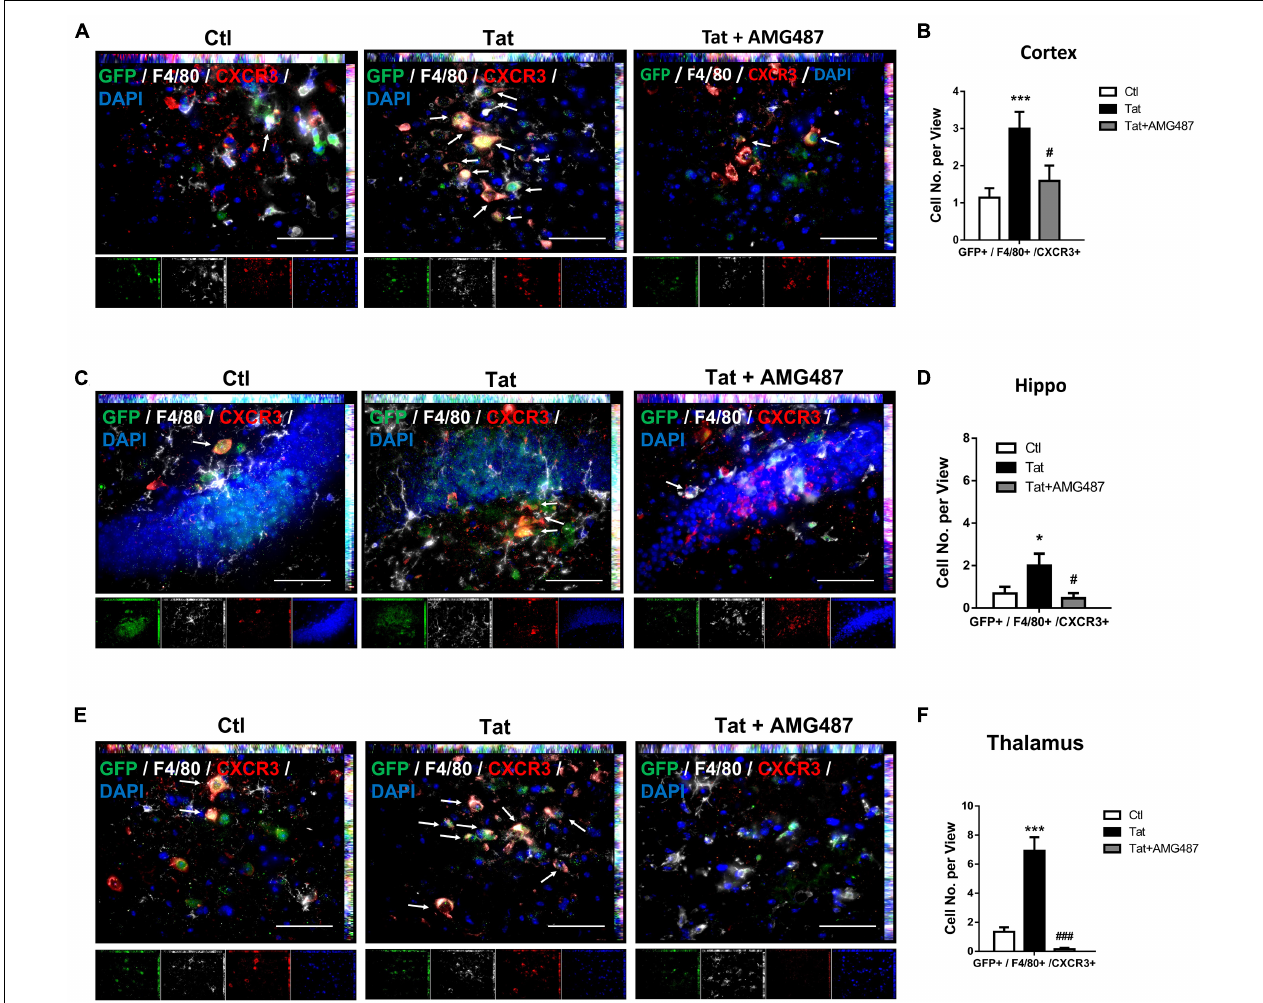
FIGURE 8 | HIV Tat-mediated upregulation of CXCR3 facilitated monocyte transmigration in mice. (A) Representative images of CXCR3+/GFP+/F4/80+ cells in the cortex of mice administrated CXCL10. n = 4 per group. Arrow: CXCR3+/GFP+/F4/80+ cells; bar, 50 µ m. (B) Quantification of CXCR3+/GFP+/F4/80+ cells in the cortex of mice administrated CXCL10. (C) Representative images of CXCR3+/GFP+/F4/80+ cells in the hippocampus of mice administrated CXCL10. n = 4 per group. Arrow: CXCR3+/GFP+/F4/80+ cells; bar, 50 µ m. (D) Quantification of CXCR3+/GFP+/F4/80+ cells in the hippocampus of mice administrated CXCL10. (E) Representative images of CXCR3+/GFP+/F4/80+ cells in the thalamus of mice administrated CXCL10. n = 4 per group. Arrow: CXCR3+/GFP+/F4/80+ cells; bar, 50 µ m. (F) Quantification of CXCR3+/GFP+/F4/80+ cells in the thalamus of mice administrated CXCL10. All data are presented as mean ± SD; five or six images per animal were analyzed. * p < 0.05 versus control group; *** p < 0.01 versus control group; # p < 0.05 versus HIV Tat group; ### p < 0.001 versus HIV Tat